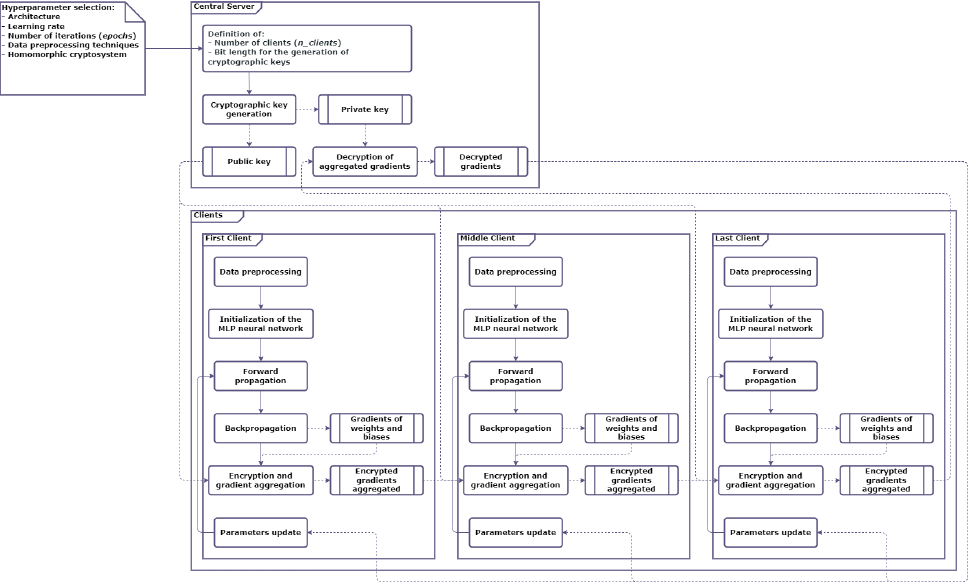
Figure 1. Inner-working of the proposed